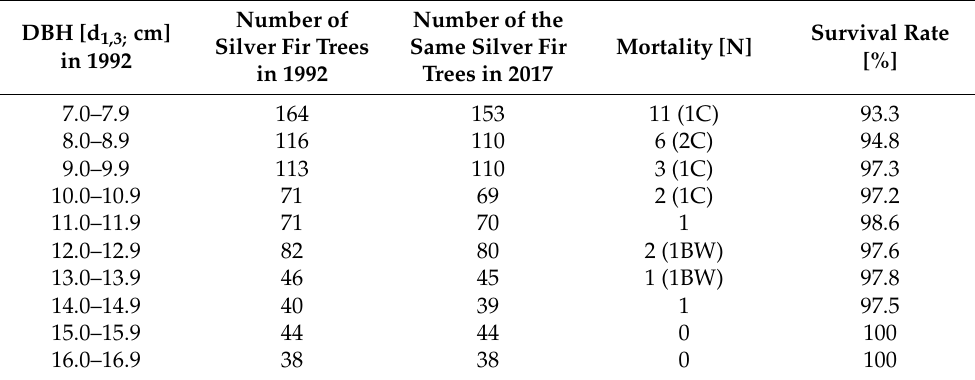
Table 7. Survivability of young silver fir trees in the area of the Gorce National Park in a period 1992–2017 assessed on a net of 433 permanent monitoring plots (0.05 ha each) distributed in the whole area of the park (for methodology see e.g., Chwistek 2010). Abbreviations: C—man-cut trees, BW—broken and windthrown